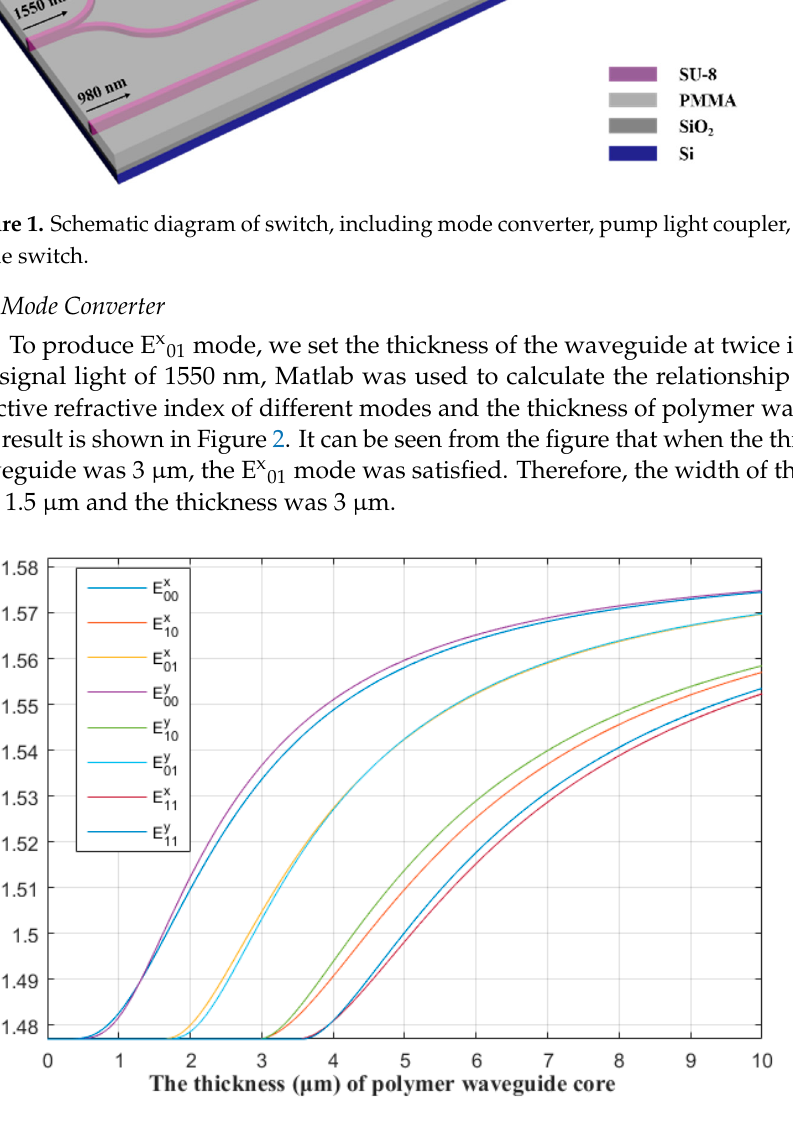
Figure 3. Schematic diagram of the mode converter. ( a ) ( b ) Figure 4. Scan results of the mode converter dimensions. ( a ) The normalized power as a function of mode converter lower arm offset; ( b ) the normalized power as a function of mode converter upper arm offset.